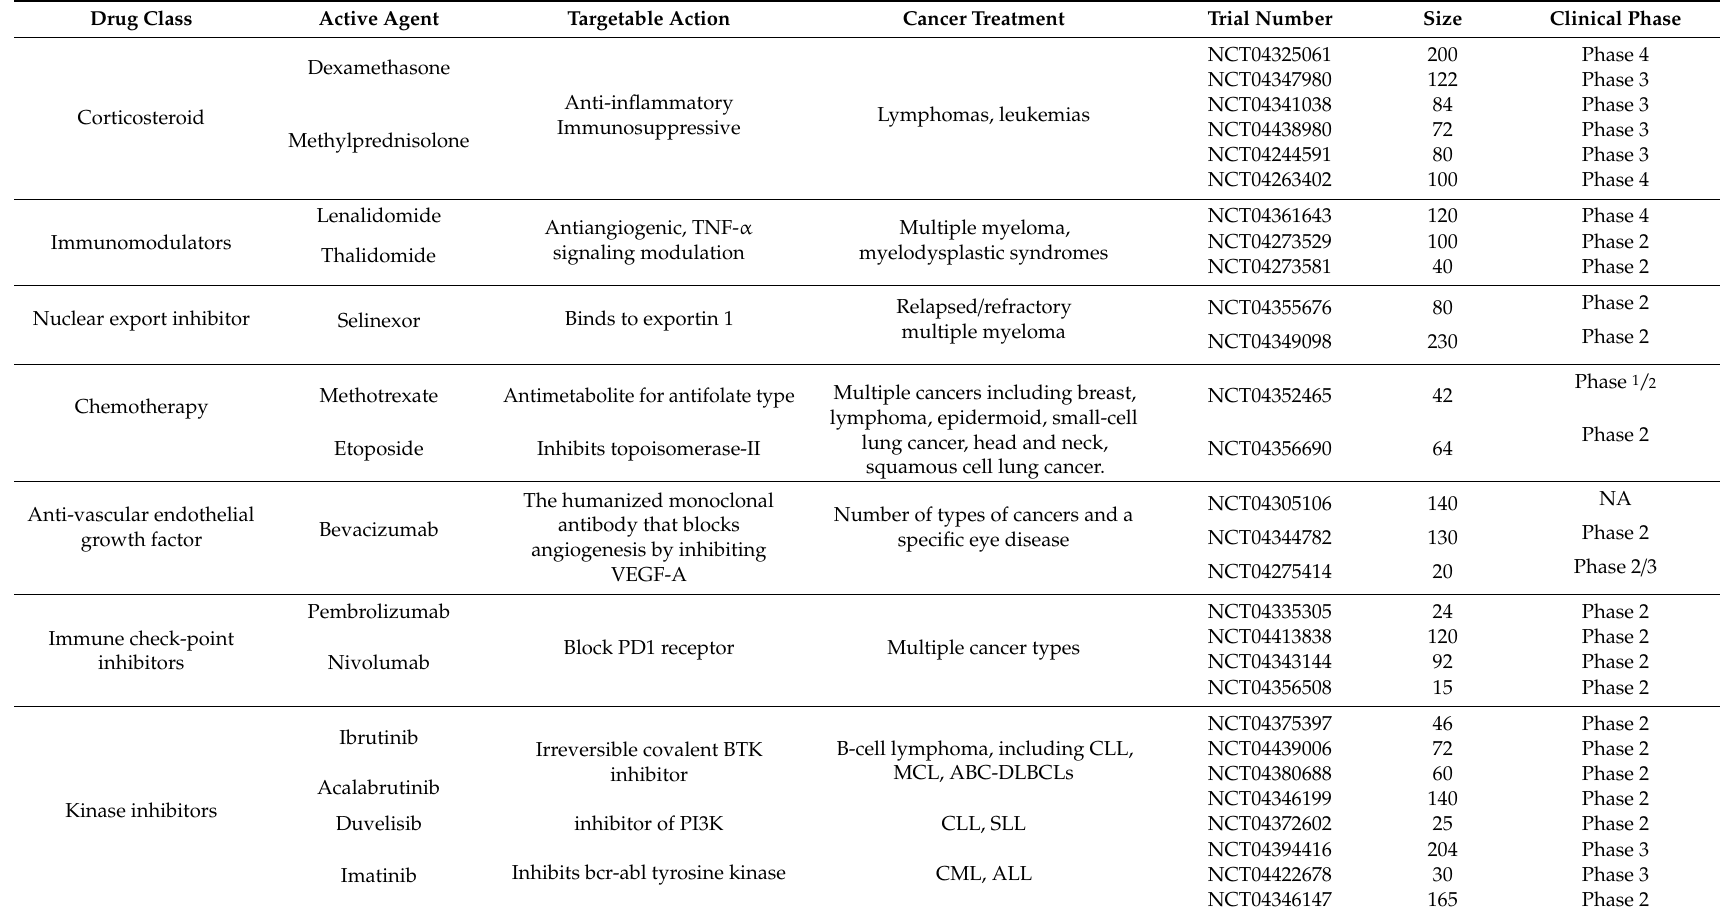
Table 2. Selected clinical trials on-going using anti-neoplastic agents for SARS-CoV-2